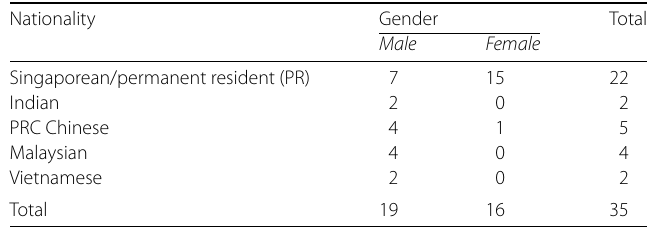
Table 2 Demography table: Number of participants by nationality and gender Nationality Gender Total Male Female Singaporean/permanent resident